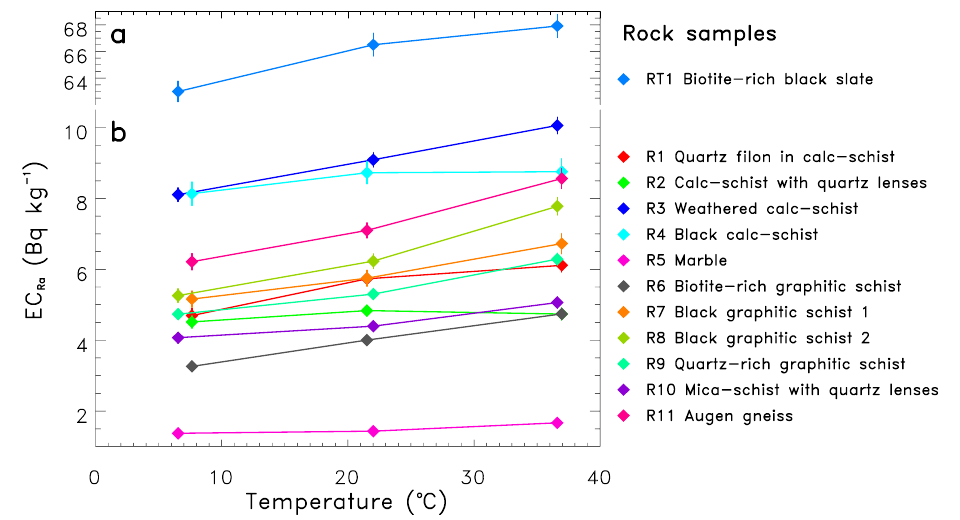
Fig. 3. EC Ra of the twelve rock samples as a function of temperature. The RT1 sample is depicted in (a) , while the eleven other rock samples Figure 4 are shown with the same vertical scale in (b) .